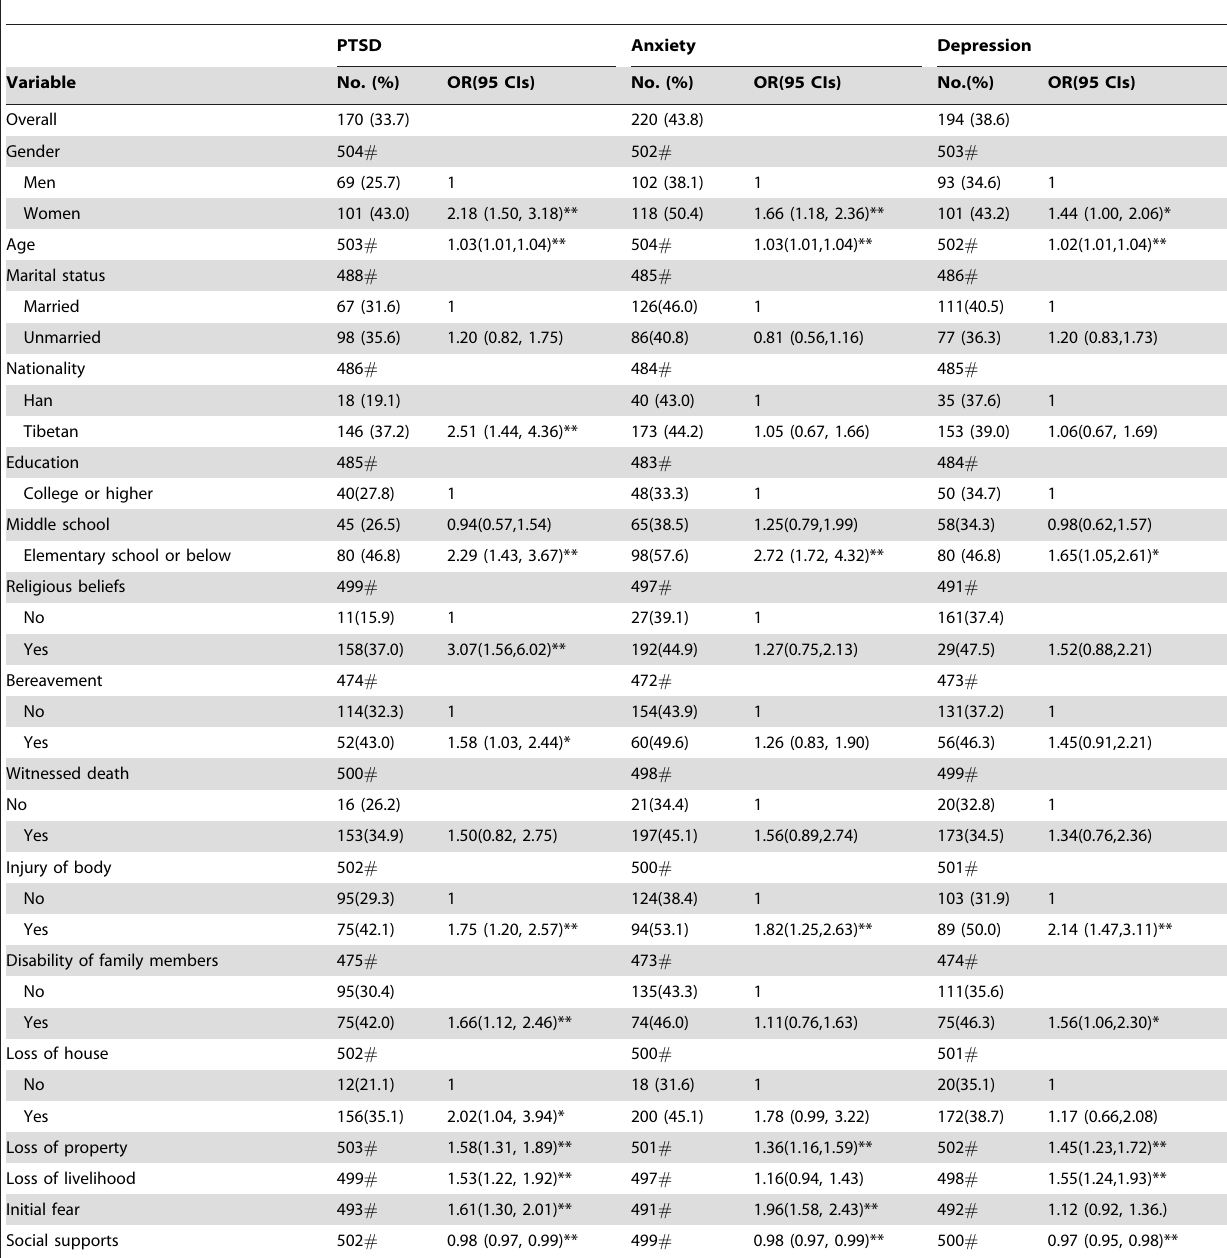
Table 3. Bivariate logistic regression analyses of the effects of demographics, trauma exposure and social support on the odds of probable PTSD, anxiety and depression.